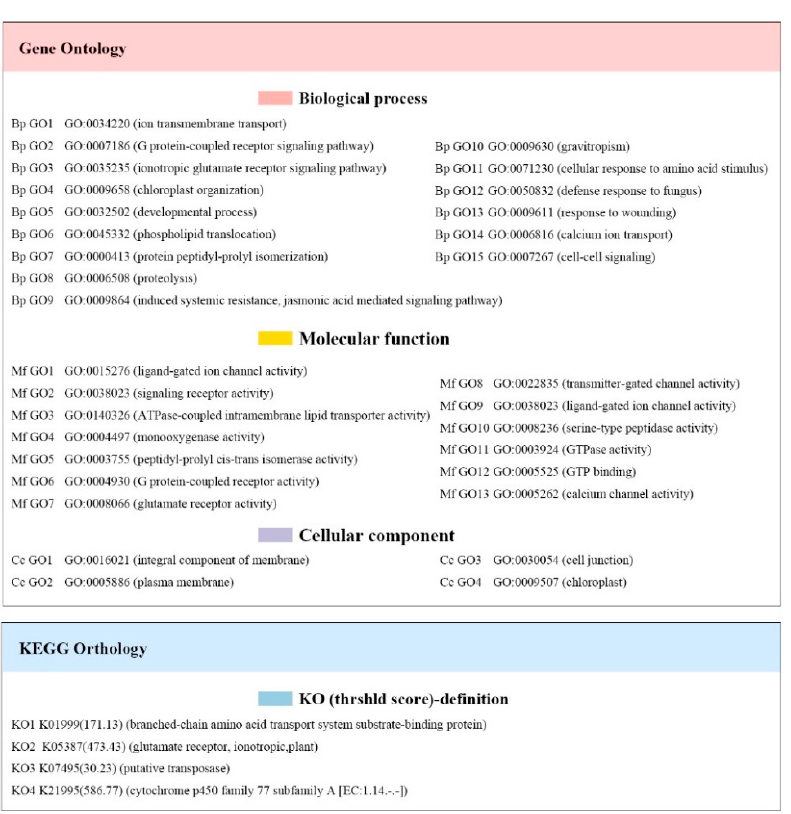
Figure 6. GO and KEGG analyses of GLR proteins from Saccharum spontaneum and Saccharum hybrid cultivar